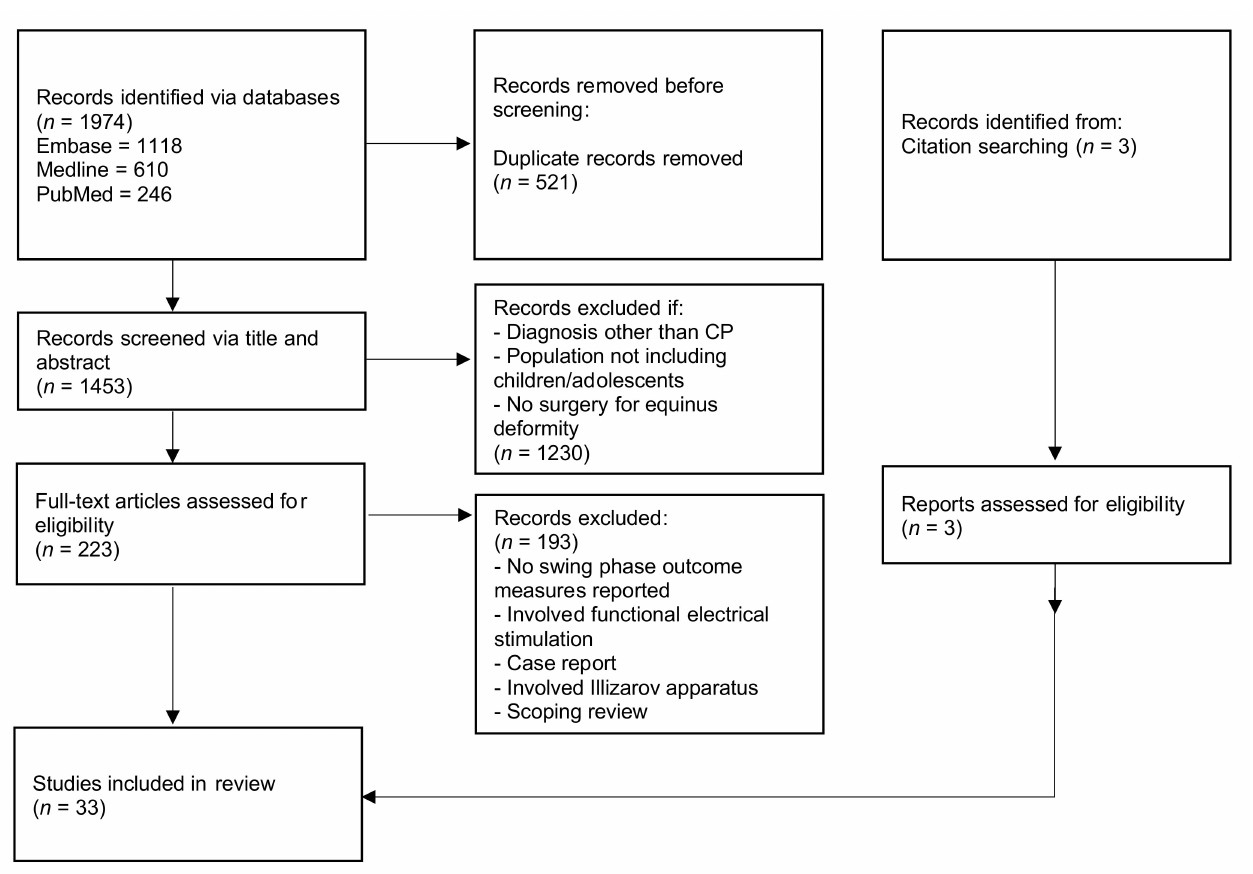
Figure 1. PRISMA